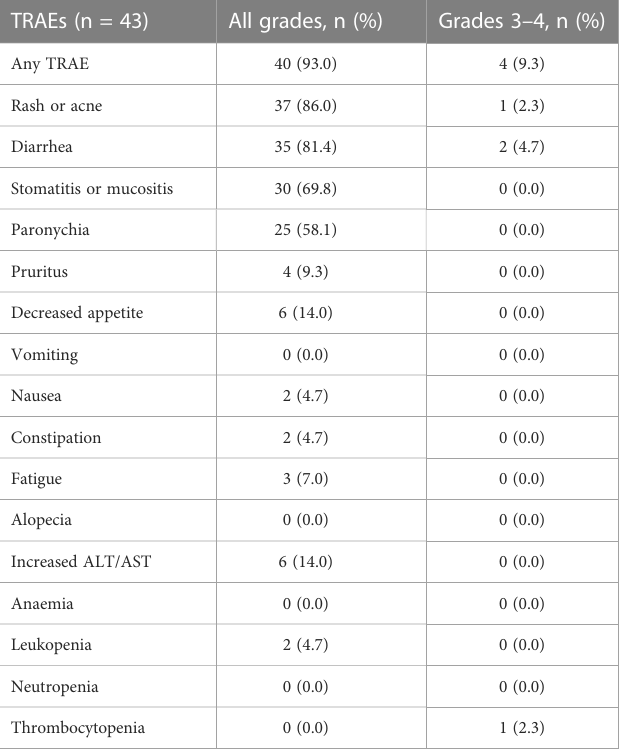
TABLE 5 TRAEs of afatinib in patients with brain